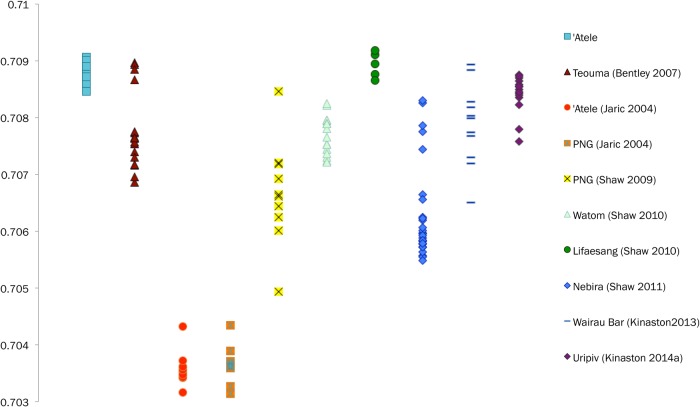
The `Atele 87Sr/86Sr ratios produced in this study compared to the 87Sr/86Sr ratios from previous prehistoric Pacific studies [78–82,101,102]Note the lower 87Sr/86Sr ratios by Jaríc [102].